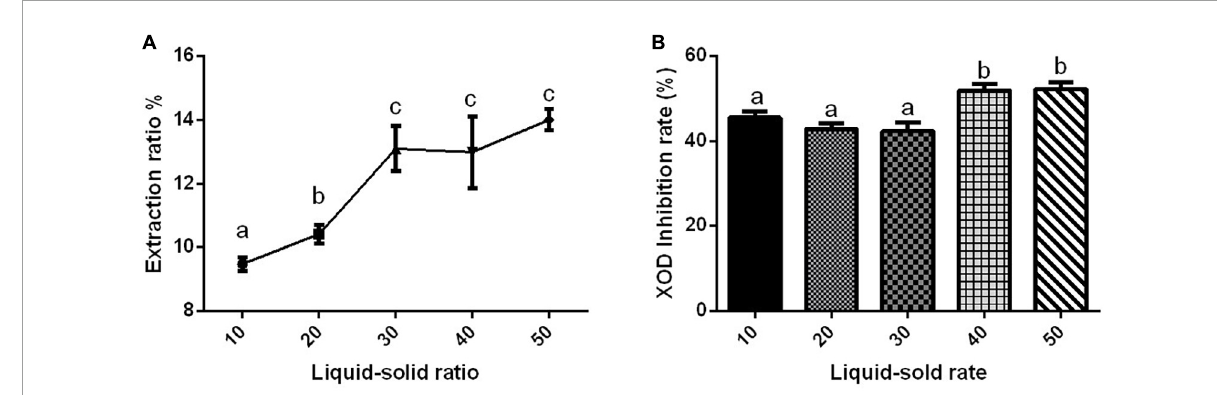
FIGURE1 The effect of liquid–solid ratio. (A) The effect of liquid–solid ratio on the extraction rate of ethanolic extract of Gym. (B) The effect of liquid–solid ratio on xanthine oxidase (XOD) inhibition rate. The different letters indicate significant difference ( P <